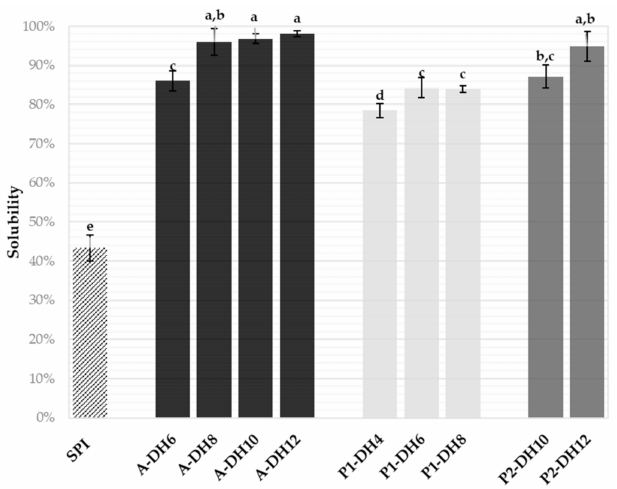
Figure 3. Solubilities of the sunflower protein isolate (SPI, 5 g · L − 1 ) and of its hydrolysates generated with Alcalase (A) and Prolyve (P1 and P2) at different degree of hydrolysis (DH) measured by the Kjeldahl method at pH 6.0 and 20 ◦ C. Values are means ( n = 3) and the error bars are the standard deviations. Samples with a common letter are not different ( p >